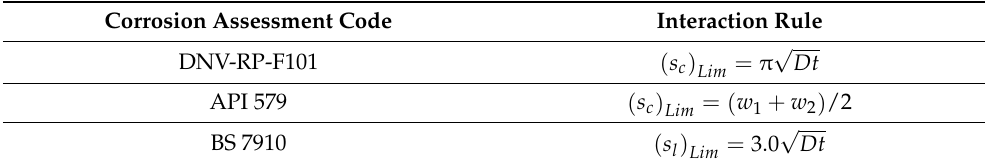
Table 2. Interaction rules applied for circumferentially aligned interacting defects in common cor- rosion assessment methods [18].